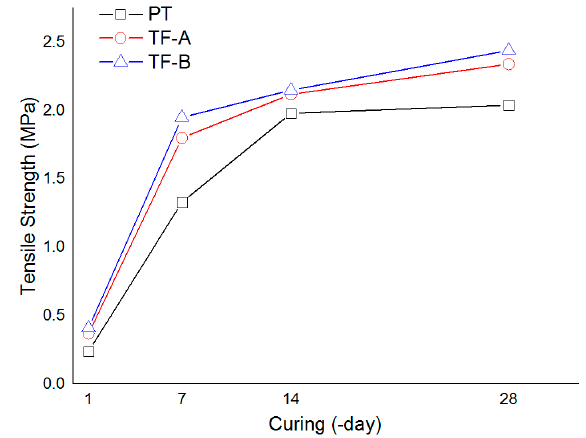
Figure 10. Relationship between average tensile strength and curing period.